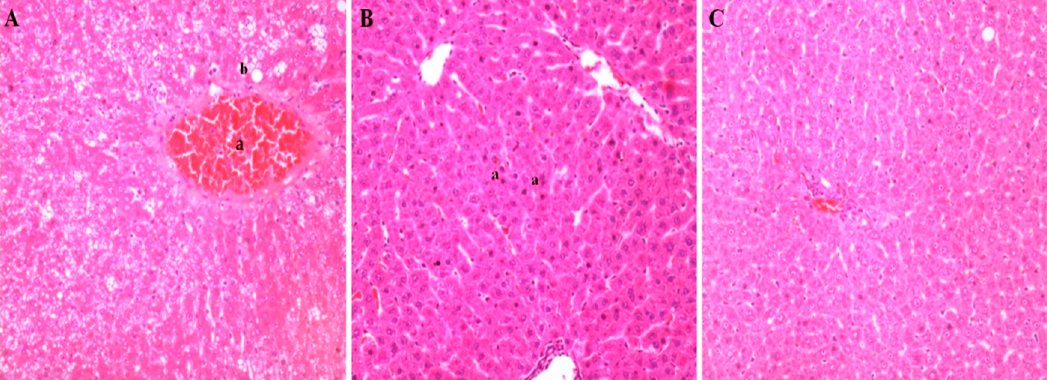
Figure 4. Histopathological liver alterations of rats fed the high-fat feed during phase 2 (Panel A ) and the high-fat feed plus betanin (Panel B ). Panel A displays centrilobular vein congestion (a), macro vesicular degenerations, andnecrosis (b). Panel B indicates normal hepatocytes suggestive of a regenerative cellular process in the high-fat group supplemented with betanin (a), with a histological architecture resembling healthy animals from the control group (Panel C ). Photographs were recorded at 20 × magnification (H&E